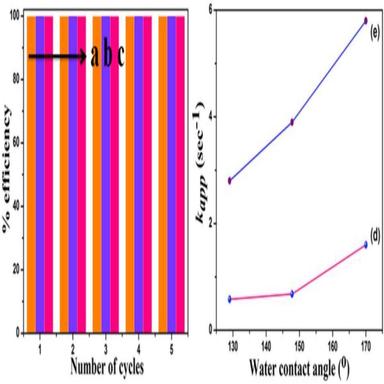
Plot of % efficiency against number of cycles of (a) Cu-PFBA, (b) Cu-SA and (c) Cu-TCPFOSi systems and plot of WCA against kapp for (d) PDC system and (e) NiP system.